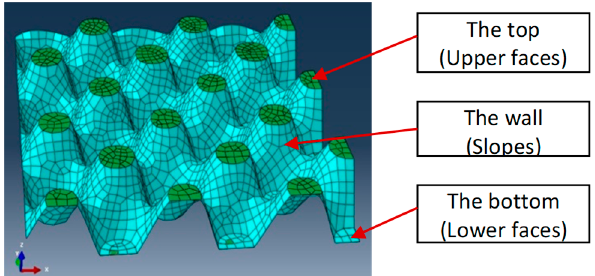
Figure 5. Top, bottom, and wall faces of the symmetric nap-core.